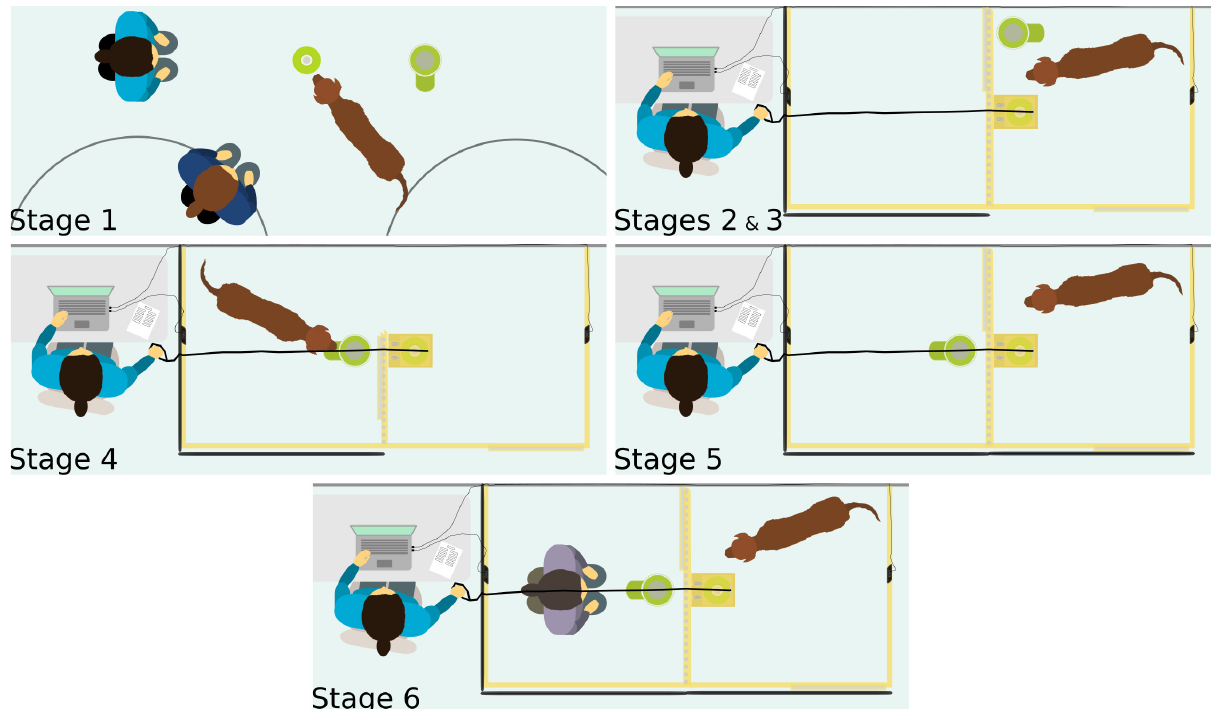
Fig 2. Stages of training. In stage 1, the owner and experimenter trained the subject to press the button to release food from the dispenser in the middle of the room. In stage 2, the subject was trained to press the button inside the permanently opened box in the enclosure to release food from the dispenser. In stage 3, opening and closing of the box was introduced (this was controlled by the experimenter pulling or releasing the rope, respectively). The subject could press the button each time the box was open to activate the dispenser. In stage 4, the dispenser was placed in the adjacent enclosure and a sliding door between enclosures was open. The subject could press the button each time the box was opened and then retrieve food from the dispenser in the adjacent enclosure. In stage 5, the sliding door between the enclosures was closed. The subject could press the button each time the box opened and food would be released from the dispenser; however, the subject could not access this food. In stage 6, the dispenser and a human were present in the adjacent enclosure. If the subject pressed the button when the box was opened, the human ate the food that was released from the dispenser. Note: in stage 6, typically a second person was not available; therefore, the experimenter played the role of the human and controlled the opening of the box while kneeling in the human enclosure.